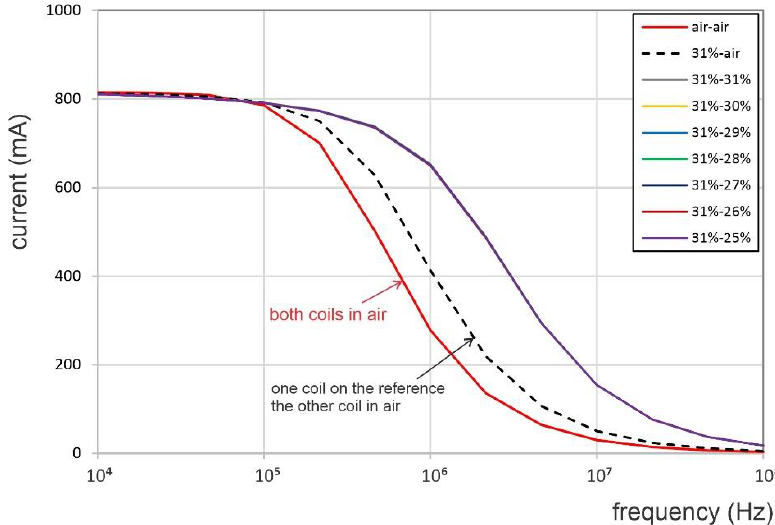
Figure 9. The value of the circuit current with frequency when the coils are either in air or on parts of different conductivities (curves are overlapping for different conductivity pairs).